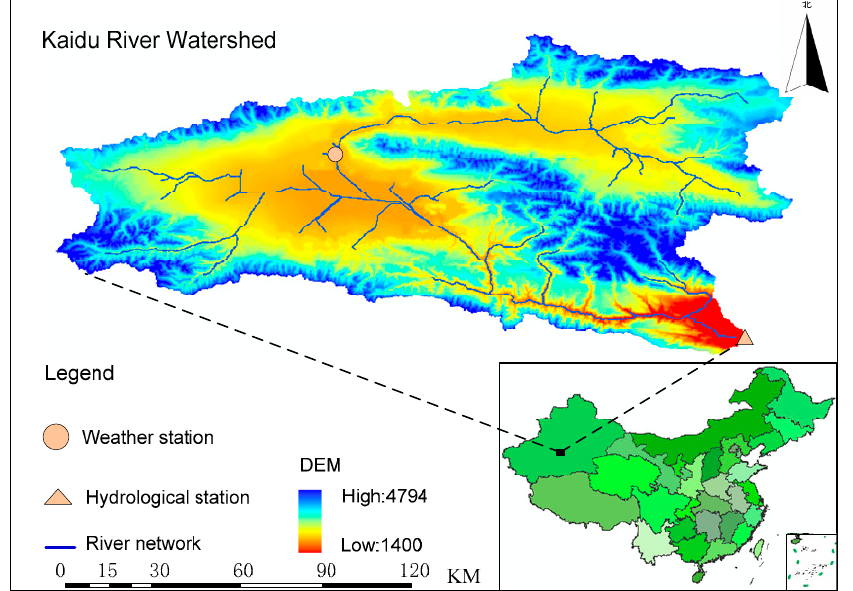
Figure 2. The Kaidu River Basin.